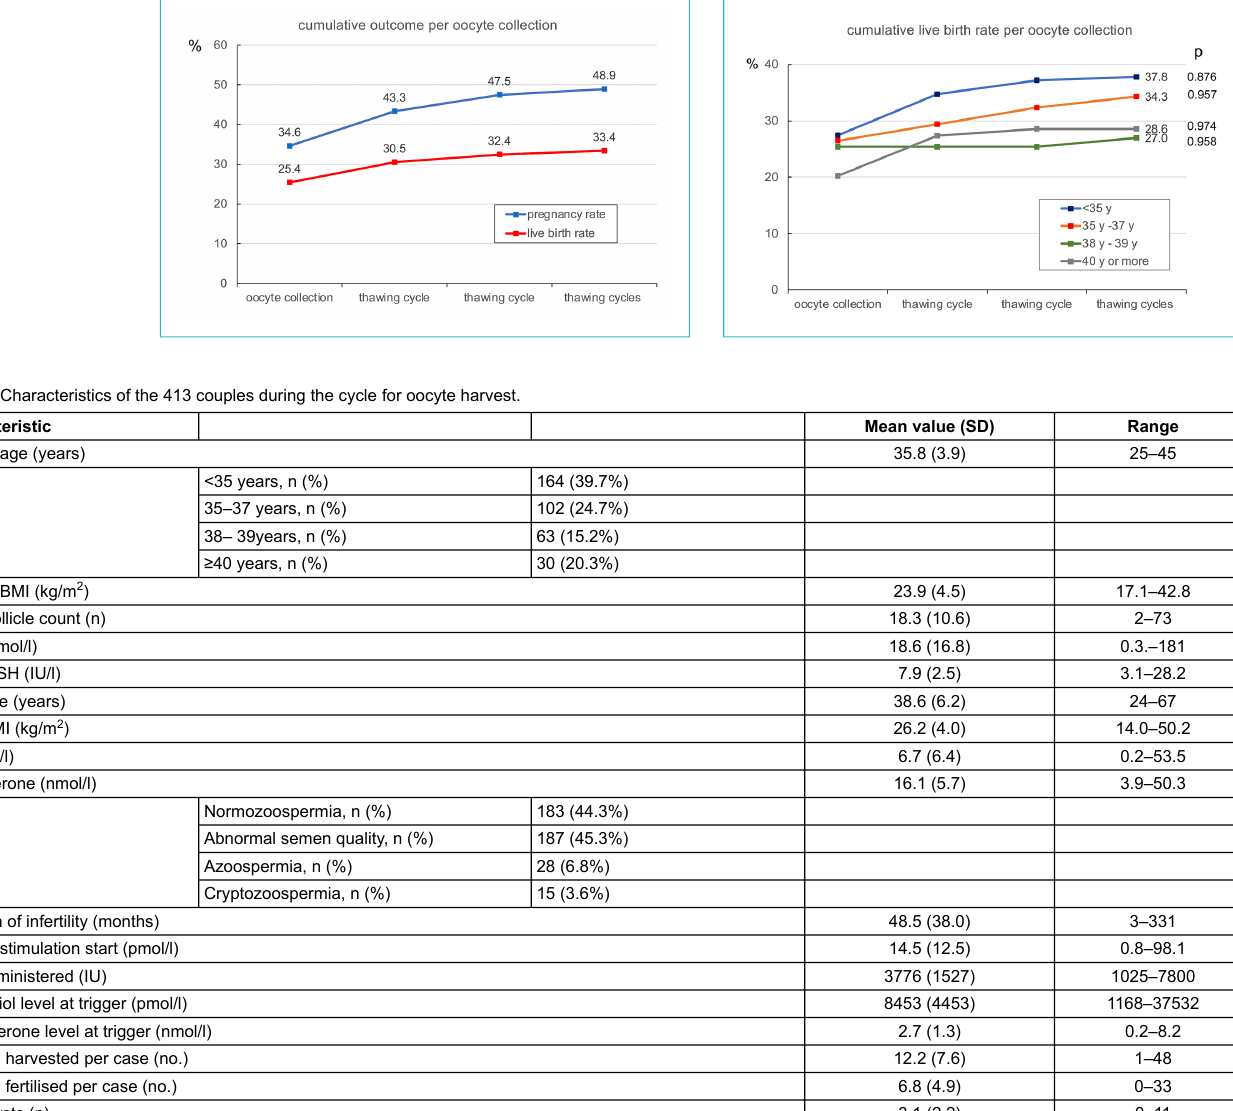
Figure 2: Cumulative pregnancy and live-birth rate during the cy- cle with oocyte collection and in subsequent thawing cycles of cry- opreserved embryos. Due to low numbers cycle 4 and 5 are sum- marised as “thawing cycles”. Only one embryo in the blastocyst stage was transferred in all treatment cycles.